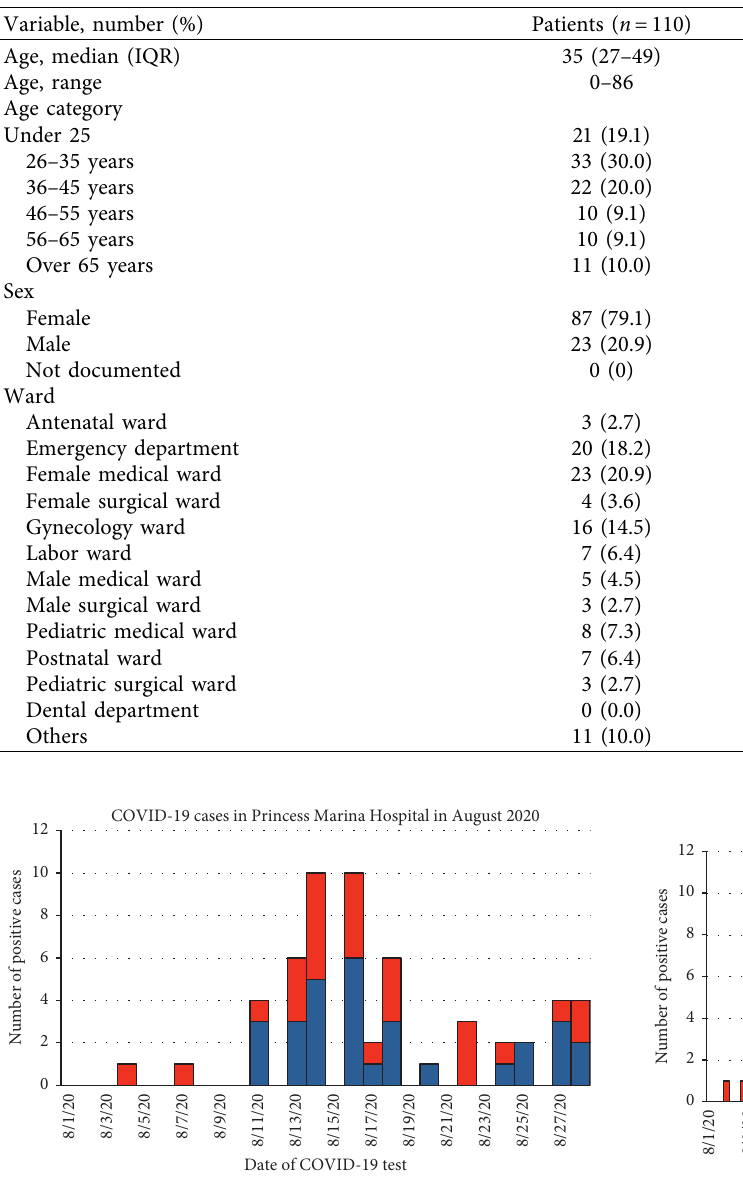
Table 2: Characteristics of cases (patients and healthcare workers).